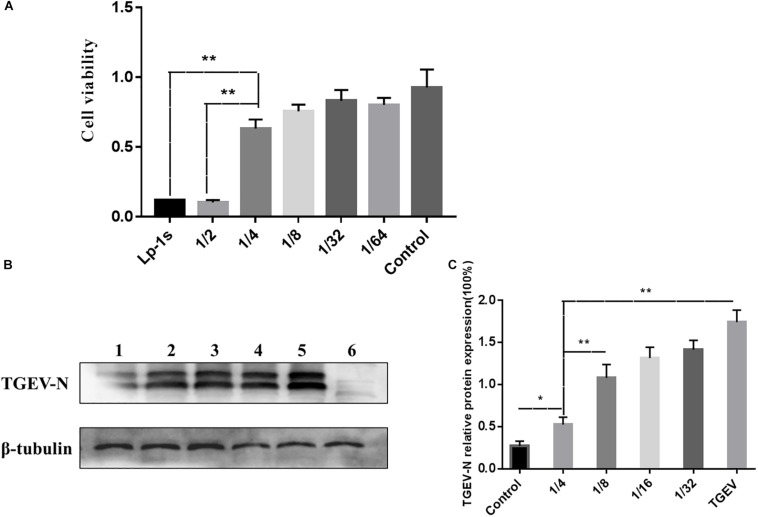
MTT cytotoxicity test and Lp-1s concentration screening. (A) Results of Lp-1s cytotoxicity as detected using the MTT method on 1/4, 1/8, 1/32, and 1/64 times dilutions of Lp-1s acting on IPEC-J2 cells. The cell adherence state remained basically unchanged. According to the experimental data, the Lp-1s undiluted group, the 1/2-fold dilution group and the 1/4-fold dilution group showed significantly difference in cytotoxicity (∗∗P < 0.01), and the 1/4-fold dilution group showed no significant difference compared with that of the control group (P > 0.05). (B) The expression of the TGEV N protein in IPEC-J2 cells treated with Lp-1s at different dilutions was detected by western blotting. Lane 1, infected TGEV group after Lp-1s 1/4 dilution pretreatment; Lane 2, infected TGEV group after Lp-1s 1/8 dilution pretreatment; Lane 3, infected TGEV group after Lp-1s 1/16 dilution pretreatment; Lane 4, infected TGEV group after Lp-1s 1/32 dilution pretreatment; Lane 5, TGEV infection group; and Lane 6, uninfected control cells (normal group). (C) Grayscale analysis of the relative expression of TGEV N in IPEC-J2 cells infected with Lp-1s at different dilutions showing that TGEV N protein levels were decreased in the 1/4-fold dilution of Lp-1s treatment group after 48 h, compared with the 1/8-fold dilution and TGEV infection group, there was a significant difference (∗∗P < 0.01), which was significantly different from the control group (∗P < 0.05).